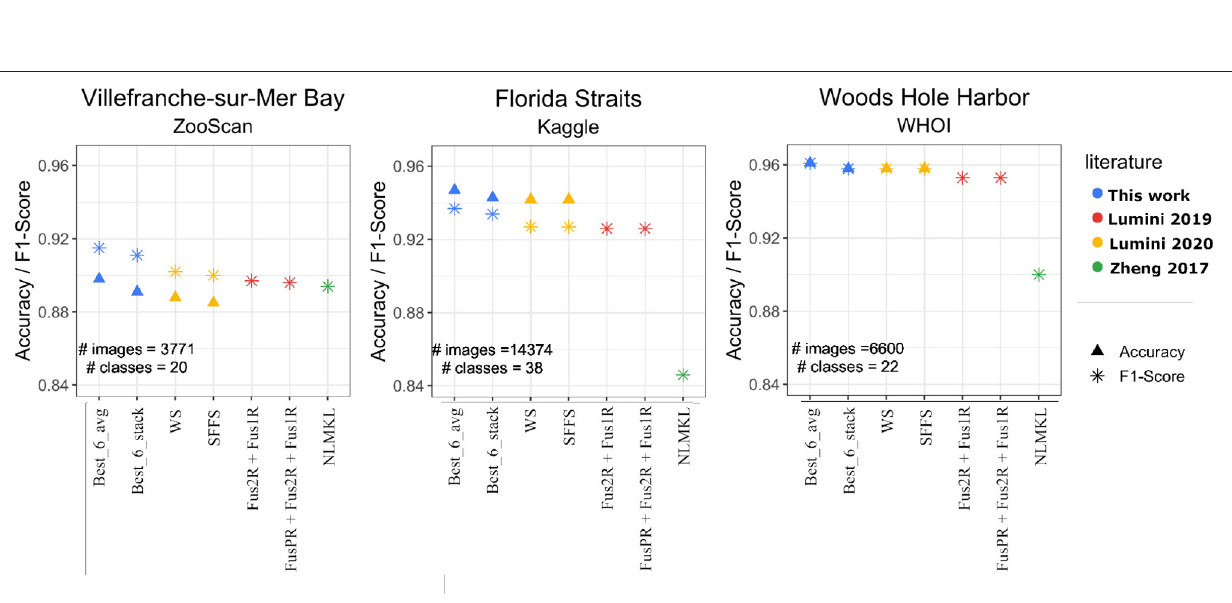
The trained image models and its corresponding feature model in each of the initial conditions were chosen from Table 1 . The bottom four lines depict the performances when using the four kinds of ensembling described in the main text. The italics represent the six models that we chose for Best_6_avg and Best_6_stack based on the validation F1-score (therefore their performance on the test set is not always the best). In bold, we represent the overall best for each sector.